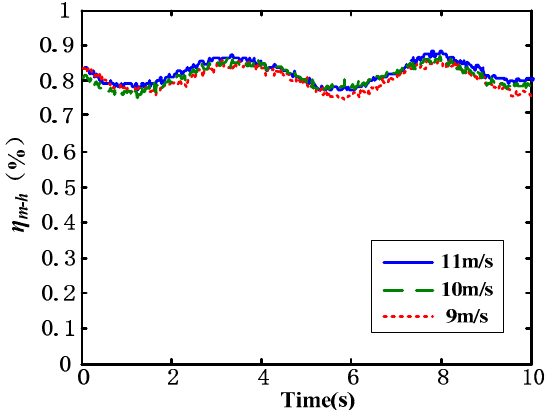
Figure 12. Efficiency experiments contrast curve of the mechanical-hydraulic system under different wind speeds.